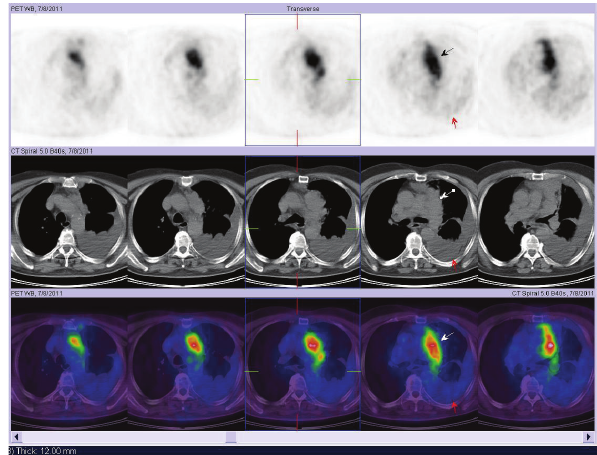
Figure 1: PET/CT scan shows intense and homogenous hyperme- tabolicactivityattheupperanteriorparamediastinalregion(SUV:7) and there was hypermetabolic lesions at the left basal pleura, which was compatible with